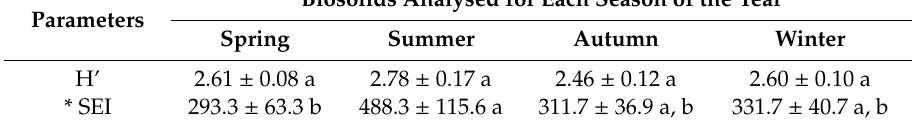
Table 4. Indices of microbial and functional diversity of biosolids collected and evaluated in the UWWTP at di ff erent season of the